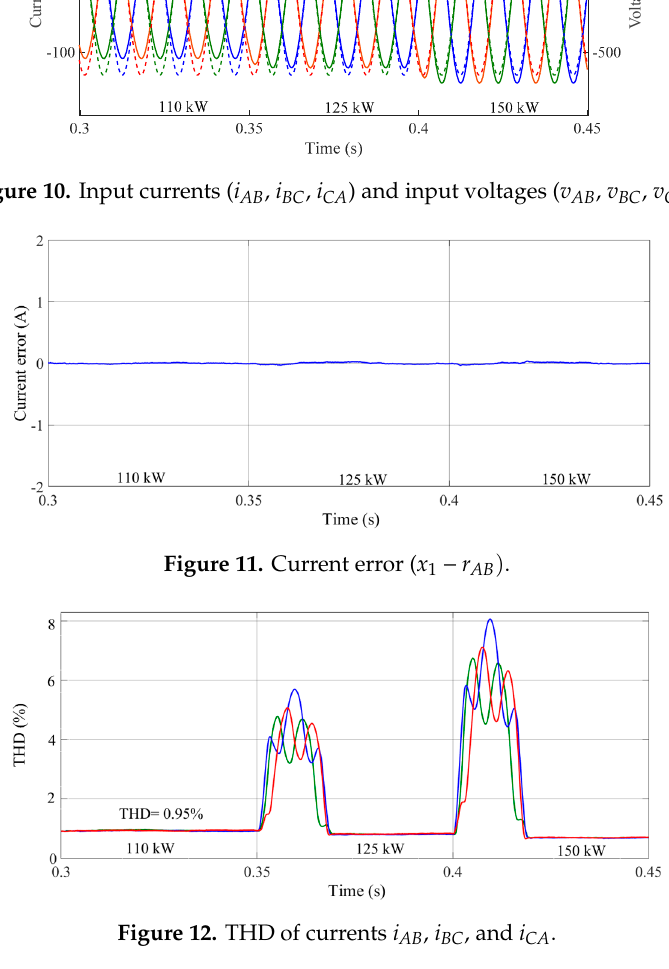
Figure 14. Output voltage 𝑉 (cid:3005)(cid:3004) during a grid voltage variation ( ± 10%). Concerning the parametric variation, the tolerance values of ± 10% in each passive device, the increase of 100% in its parasitic series resistance, and a 100% increase in the on-resistance of power semiconductors are evaluated. For the 10% case, the currents 𝑖 (cid:3002)(cid:3003) , 𝑖 (cid:3003)(cid:3004) , and 𝑖 (cid:3004)(cid:3002) track the corresponding references (with an error near to zero) and are in phase with the voltages 𝑣 (cid:3002)(cid:3003) , 𝑣 (cid:3003)(cid:3004) , and 𝑣 (cid:3004)(cid:3002) , respectively (see Figure 15). As a consequence, the indirectly regulated voltage behaves as shown in Figure 16, where the highest voltage error is 1.4% when the converter delivers 150 kW.